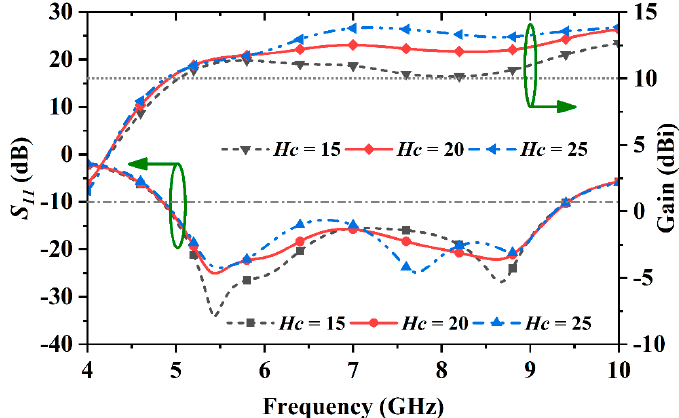
Figure 11. The S 11 and boresight gains for different values of Hc .